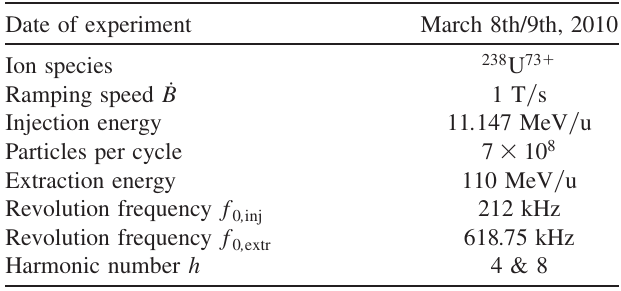
TABLE II. Parameters for dual-harmonic